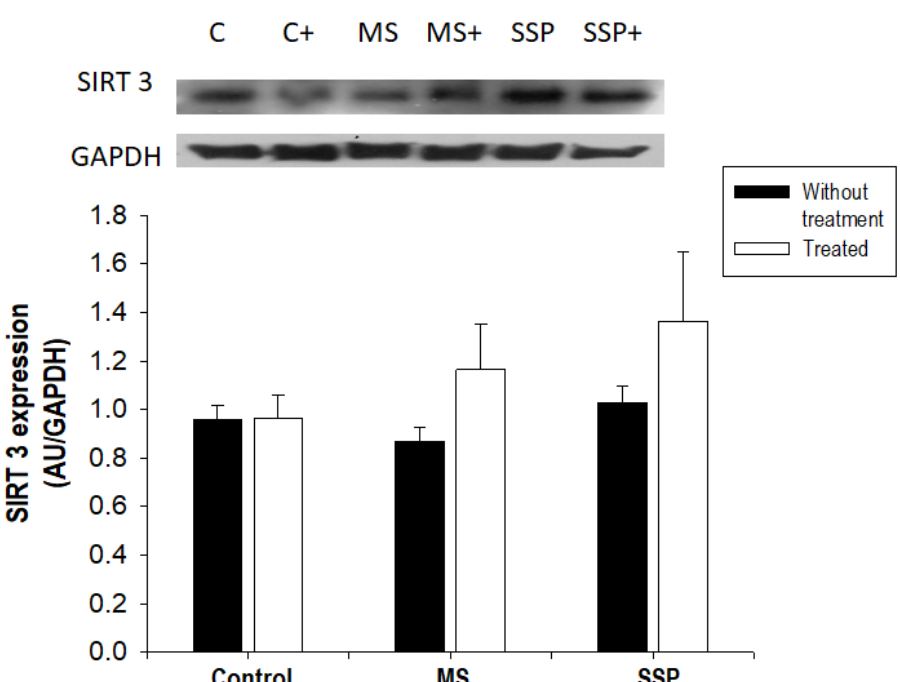
Figure 8. The e ff ects of the long-term (MS) and short-term (SSP) administration of sucrose and polyphenol treatment on the protein expression of SIRT 3. A representative Western blot image is shown. Data represent the mean ± SEM of five di ff erent rats from each group. Abbreviations: C = control; C + = control treated with polyphenols; MS = metabolic syndrome; MS + = metabolic syndrome treated with polyphenols; SSP = short sucrose period; SSP + = short sucrose period treated with polyphenols.